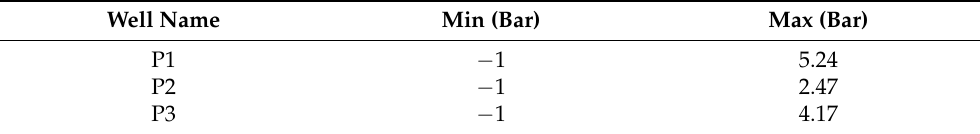
Table 4. The shut-in bottom hole pressures uncertainty for production